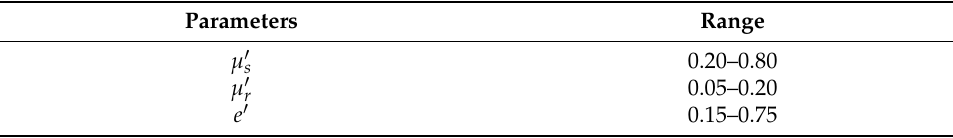
Table 1. The ranges of the simulation parameters of pellet–pellet.